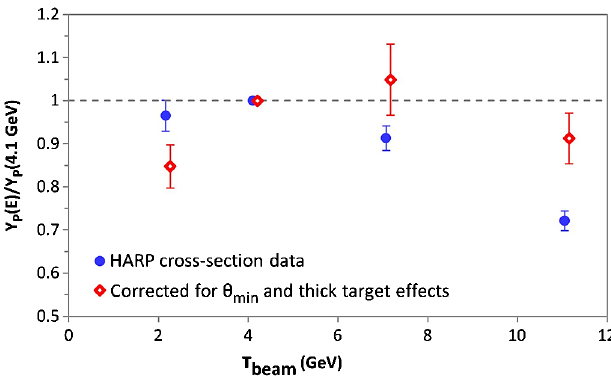
FIG. 9. Beam-power normalized muon yield at the end of the NF/MC front-end channel, relative to that at T beam ¼ 4 : 1 GeV . The results with and without the corrections are displaced þ 50 and (cid:1) 50 MeV , respectively, for clarity of